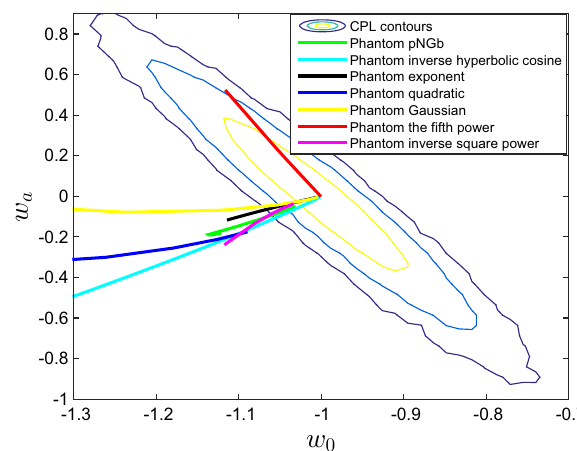
Fig. 1 The comparison of the possible (w 0 ,w a ) values of the quintessence dark energy potentials with the CPL- Λ CDM 3 σ confi- dence level contours